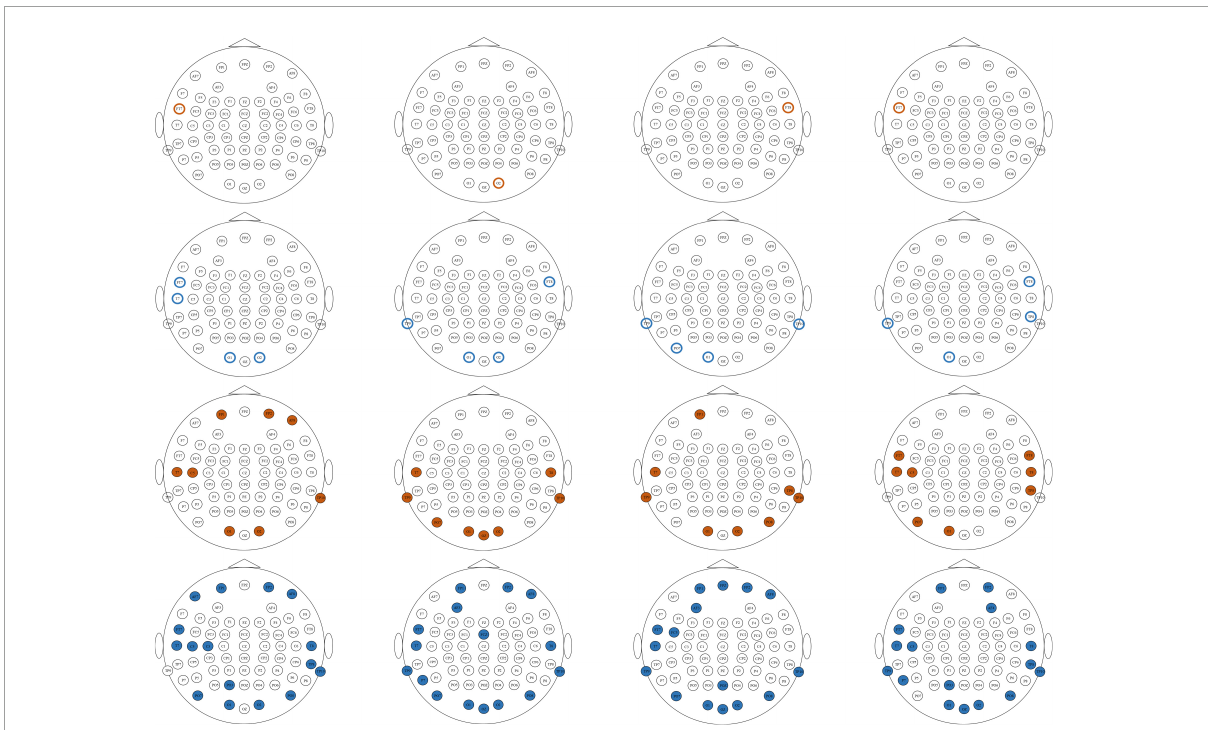
FIGURE6 The distribution of the most important1, 4, 8, and 16 electrodes on the ESD dataset. Brown circles mark the most important 1 electrode, blue circles mark the most important 4 electrodes, brown solid circles mark the most important 8 electrodes, and blue solid circles mark the most important 16 electrodes. From top to bottom, each row corresponds to first-order difference, second-order difference, high gamma band power, and high gamma band DE,